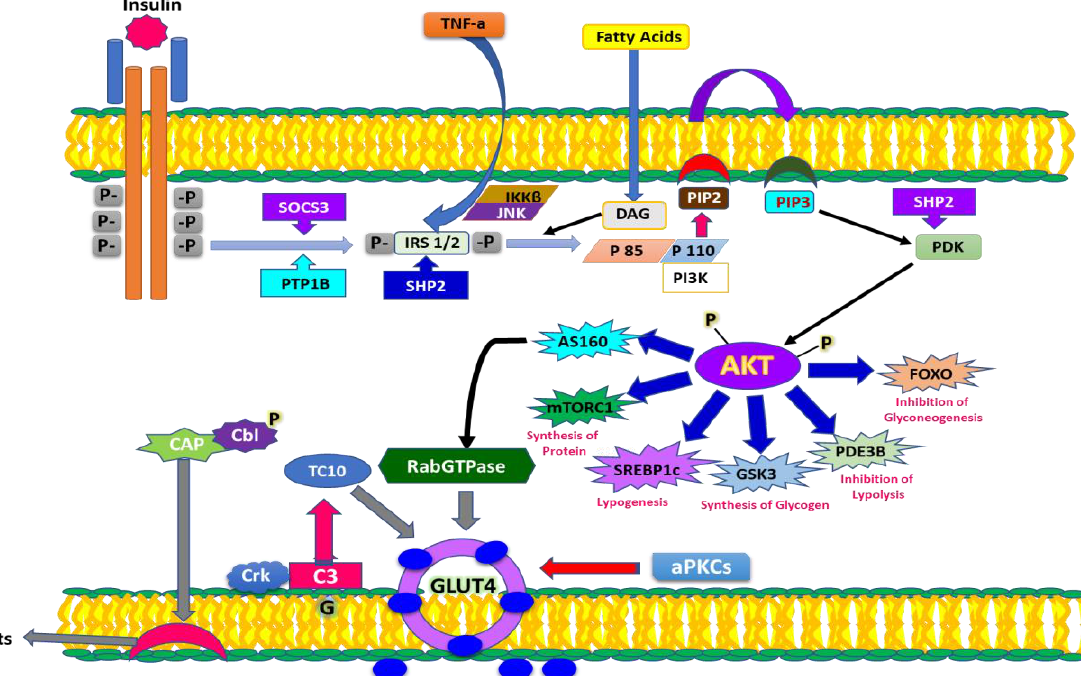
Figure 4. Mechanism of insulin action and factors involved in signaling.